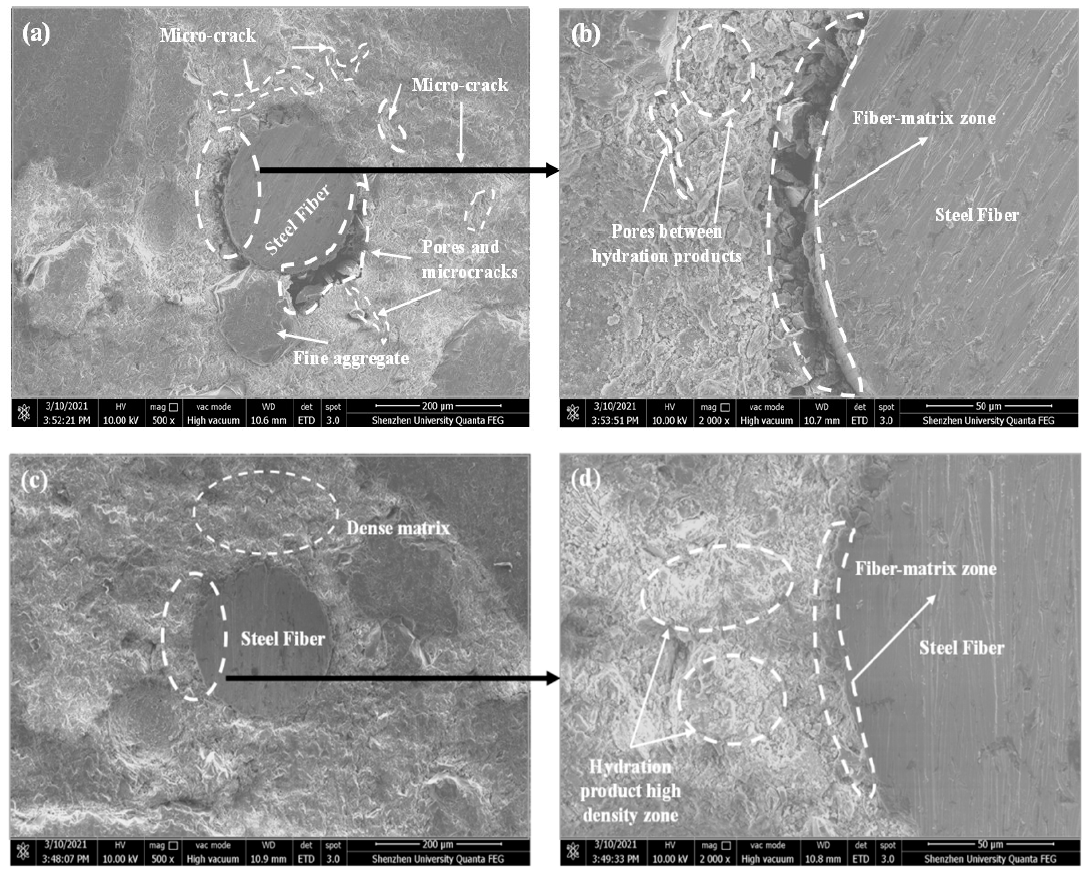
Figure 10. SEM image of 28d FR-AASC: ( a , b ) without HEDP.4Na; ( c , d ) with addition of 0.3%-HEDP.4Na.